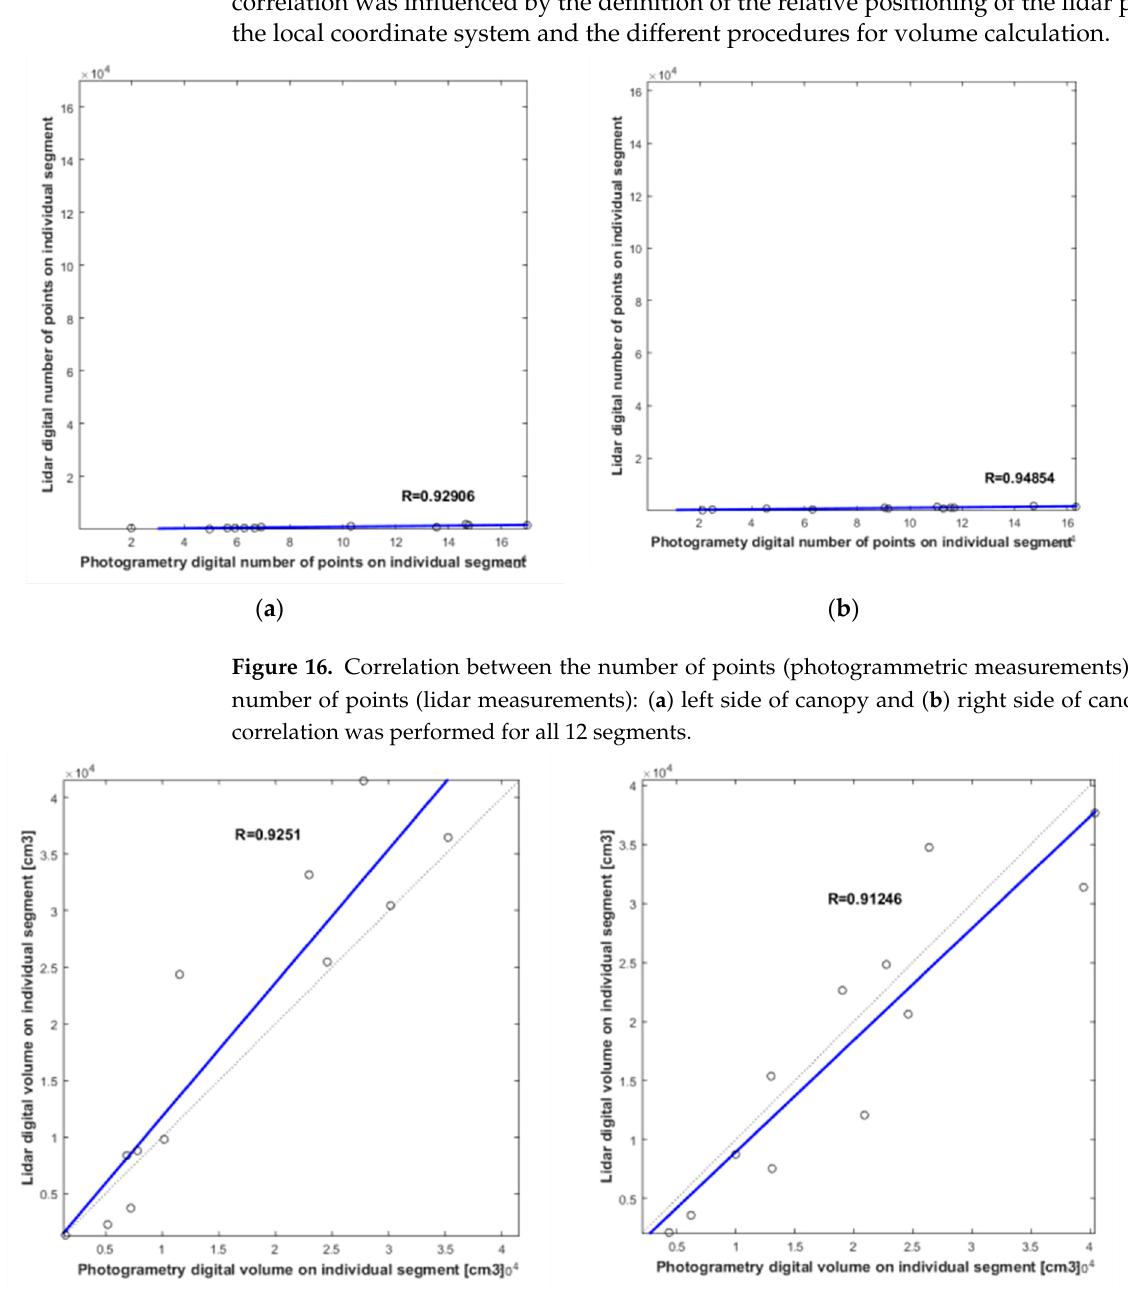
Figure 15. Correlation between vine canopy volume (photogrammetric measurements) and leaf area (manual measurements): ( a ) left side of vine canopy and ( b ) right side of vine canopy. Correlation was performed for all 12 segments.